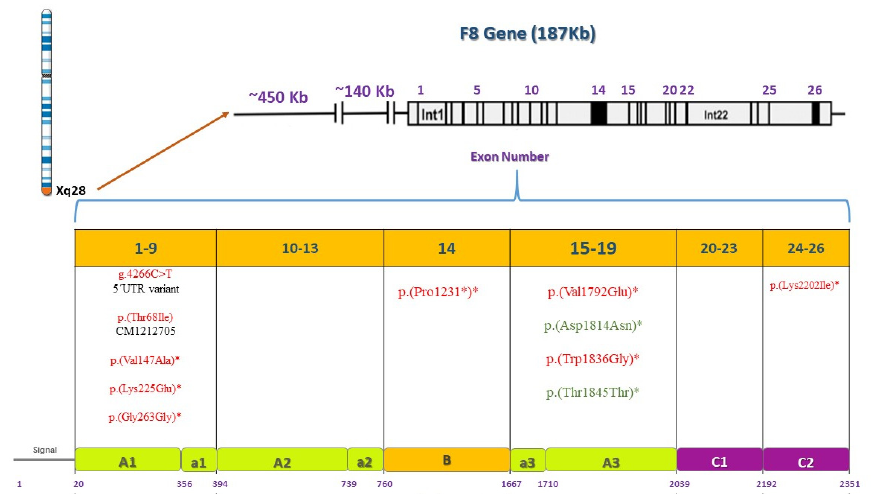
Figure 8. Pathogenic or benign variations found by F8 gene and protein domain. F8 is located on the X chromosome, 26 exons are shown and their corresponding domains and motifs in the F8 protein. Deleterious variations appear in red and benign variations in green. Asterisks indicate novel variations found.